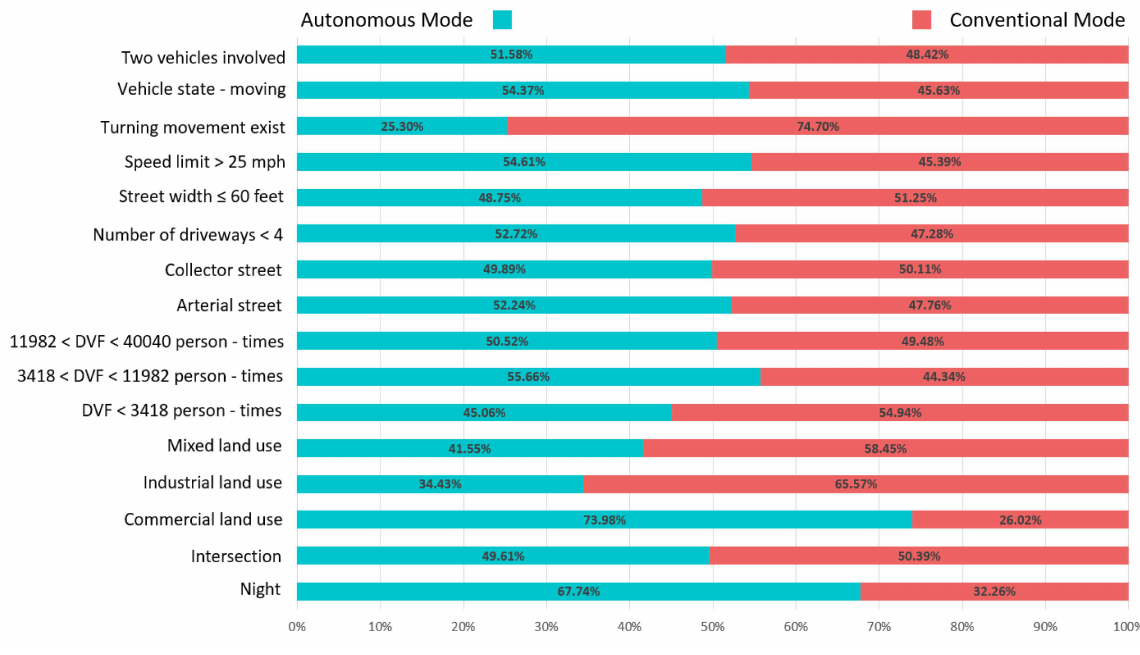
Figure 1. A comparison of driving conditions in both driving modes. Table 1. Descriptive statistics of continuous